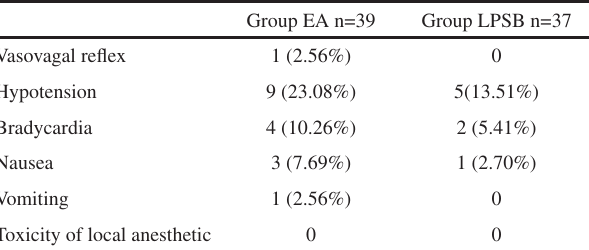
Table 4 - The frequency of complications after completion of regional anesthetic techniques expressed as number of patients and percentage per